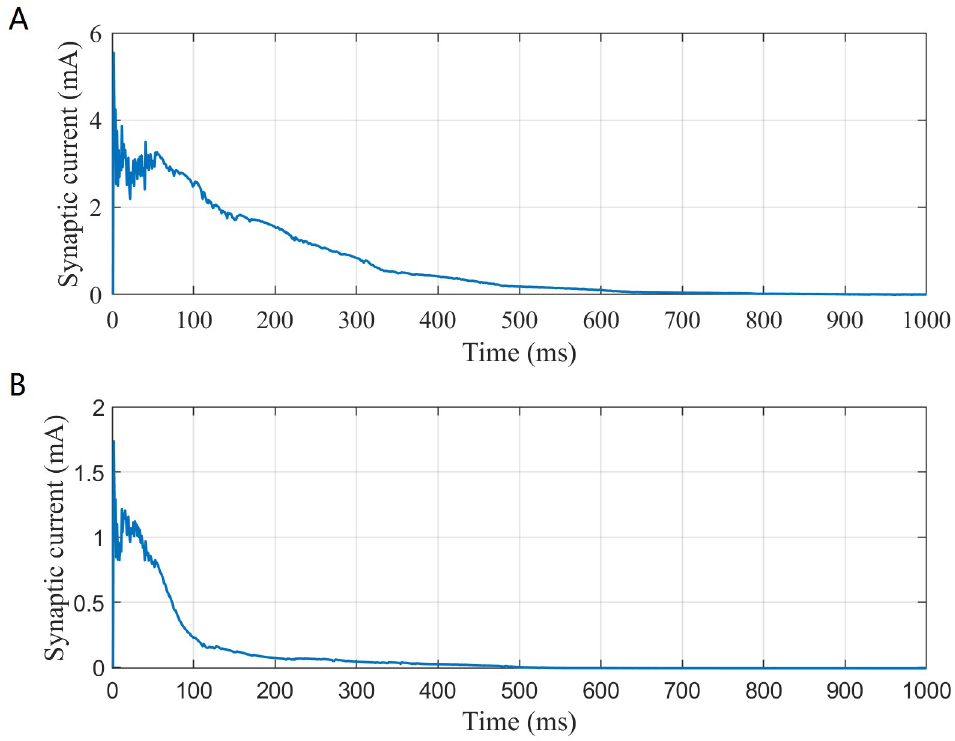
Fig 16. The change in the synaptic current with time. (A) The excitatory current. (B) The inhibitory current. And according to formula (2), it can be found that the change of synaptic weight g change synaptic currents I . And the synaptic currents include excitatory and inhibitory cur- syn rents. In this study, excitatory synaptic current is the mean of excitatory current received by all postsynaptic neurons; inhibitory synaptic current is the mean of inhibitory current received by all postsynaptic neurons. To investigate the change in the inhibitory and excitatory synaptic currents with time under white Gaussian noise, their dynamic evolution are illustrated in Fig 16. From Fig 16, the excitatory current drops sharply in the first 200 ms, drops slowly from 200